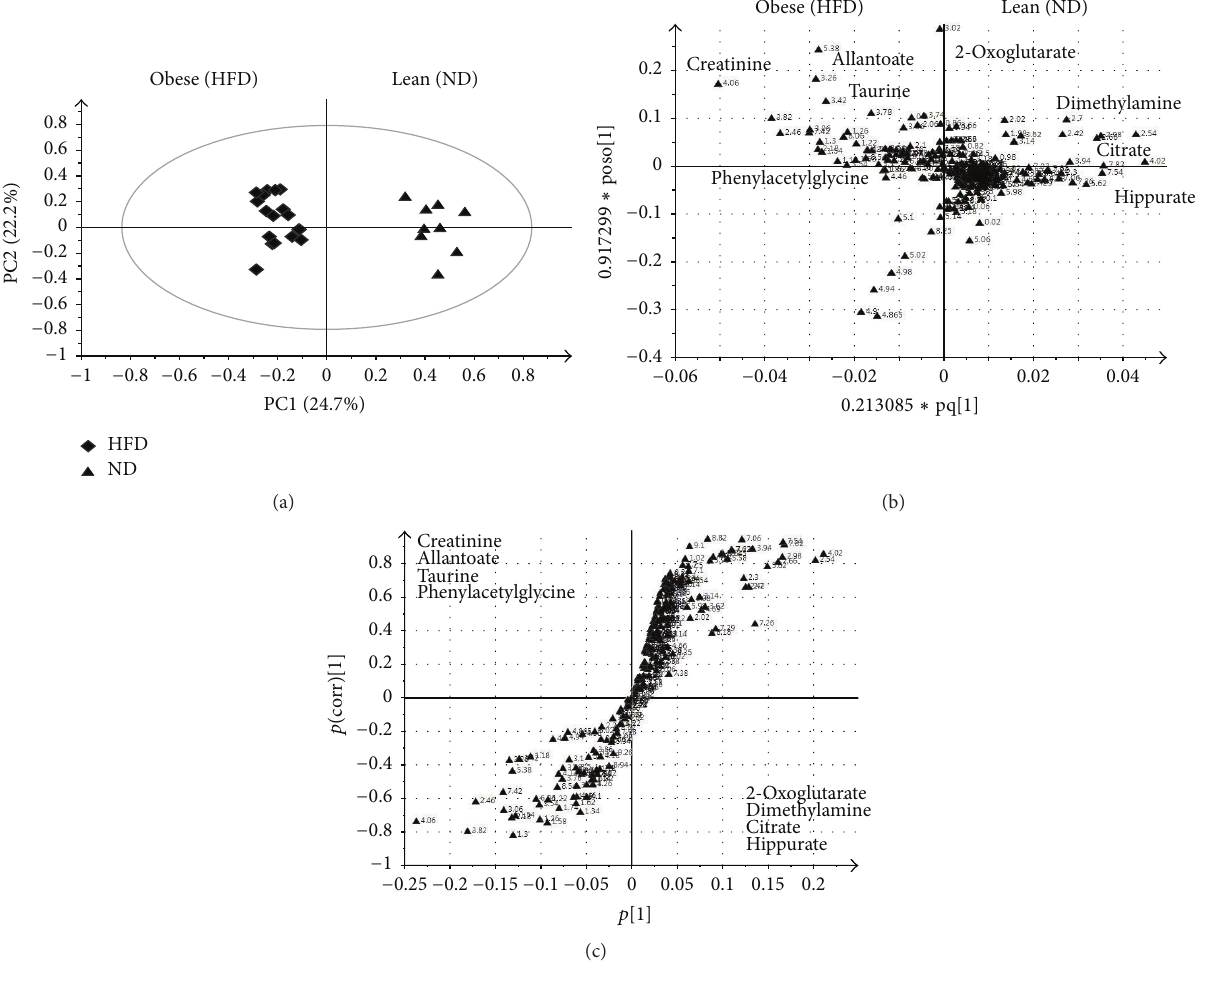
Figure 5: OPLS-DA derived score plot (a), loading plot (b), and 𝑆 plot (c) obtained using 1 H NMR data for urine samples from Sprague- Dawley rats fed a high fat diet (HFD) or a normal diet (ND) for 12